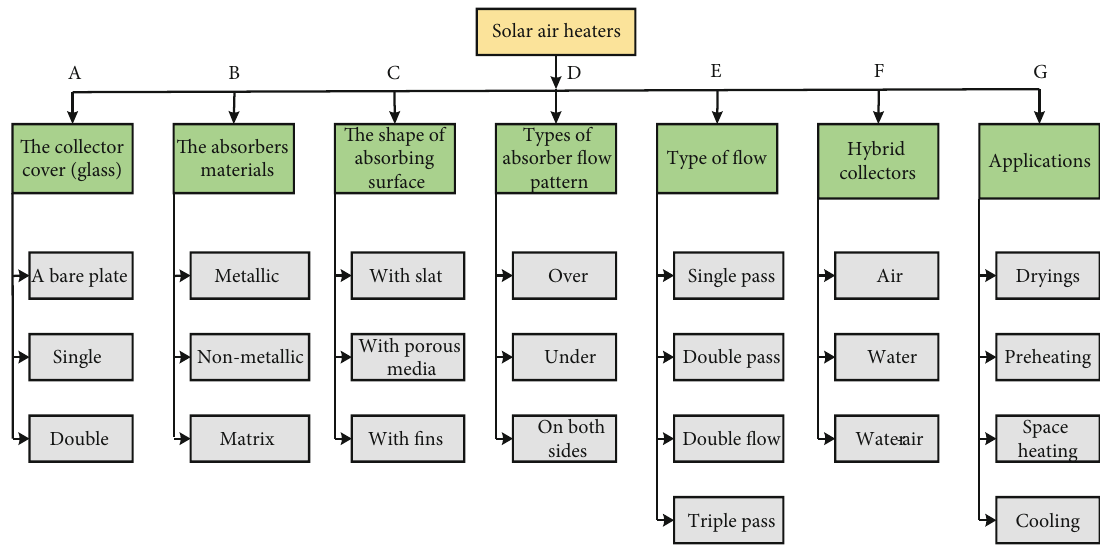
Figure 3: Distribution of solar air heaters based on Ghritlahre et al.